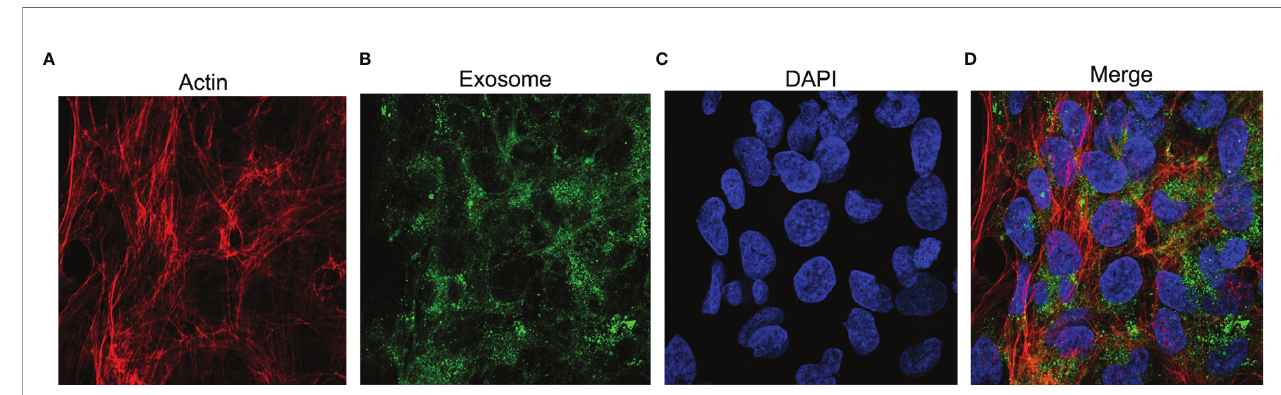
were used to simultaneously detect the expression levels of osteoblast markers. The protein levels of ALP, OPG, and RANKL are presented in Figure 3D . The results showed that there were no signi fi cant changes in the expressions of ALP, OPG, and RANKL between blank control and NC group, while the levels of OPG and ALP were down-regulated and the level of RANKL was up-regulated in the MSU group.